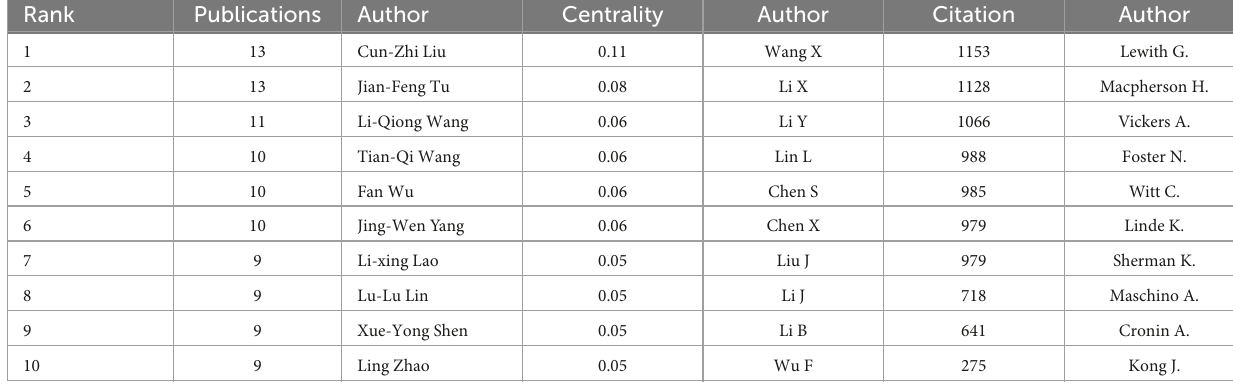
TABLE 5 Top 10 authors related to Chinese non-pharmacological therapy on KOA.